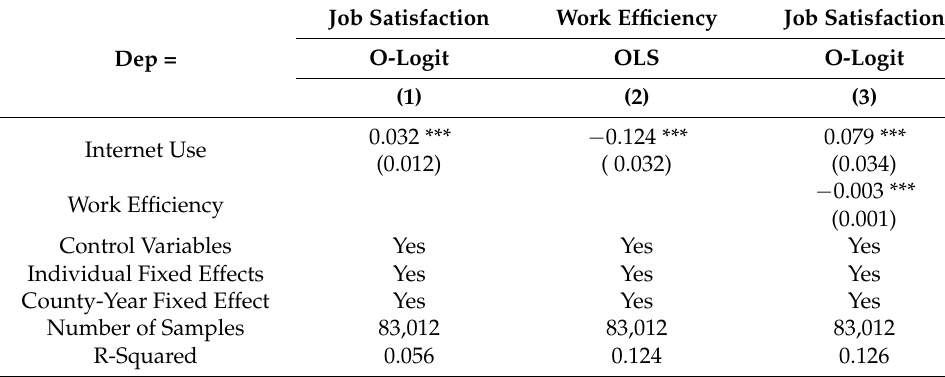
Table 10. Internet Use, Work Efficiency and Job